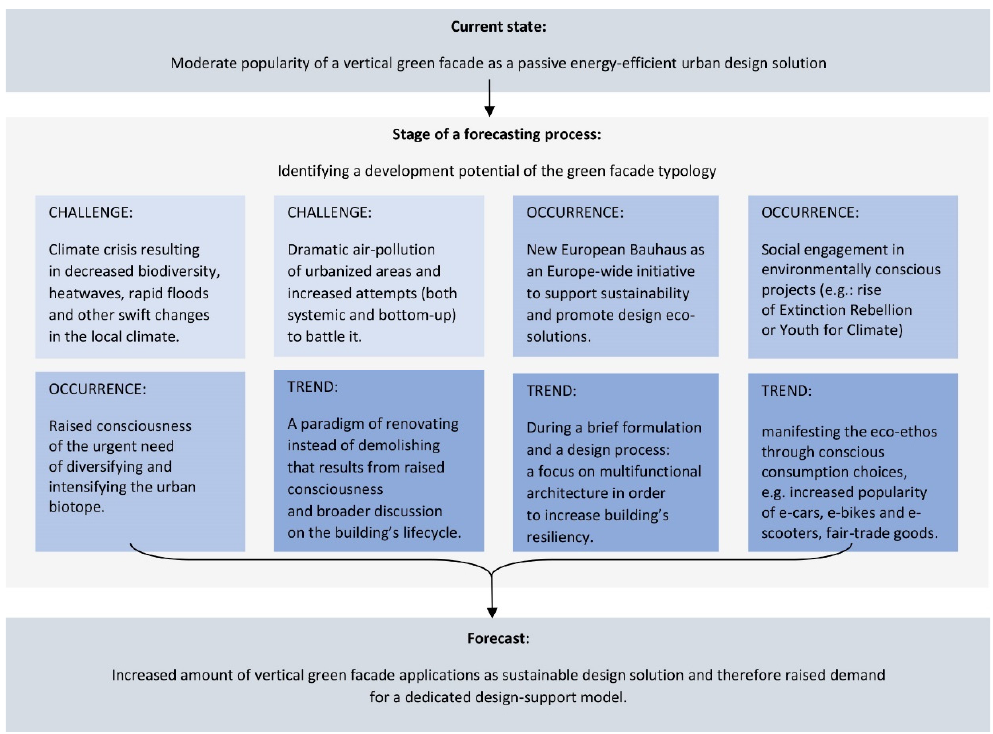
Figure 3. The forecasting scheme for diagnosing the application’s potential demand.